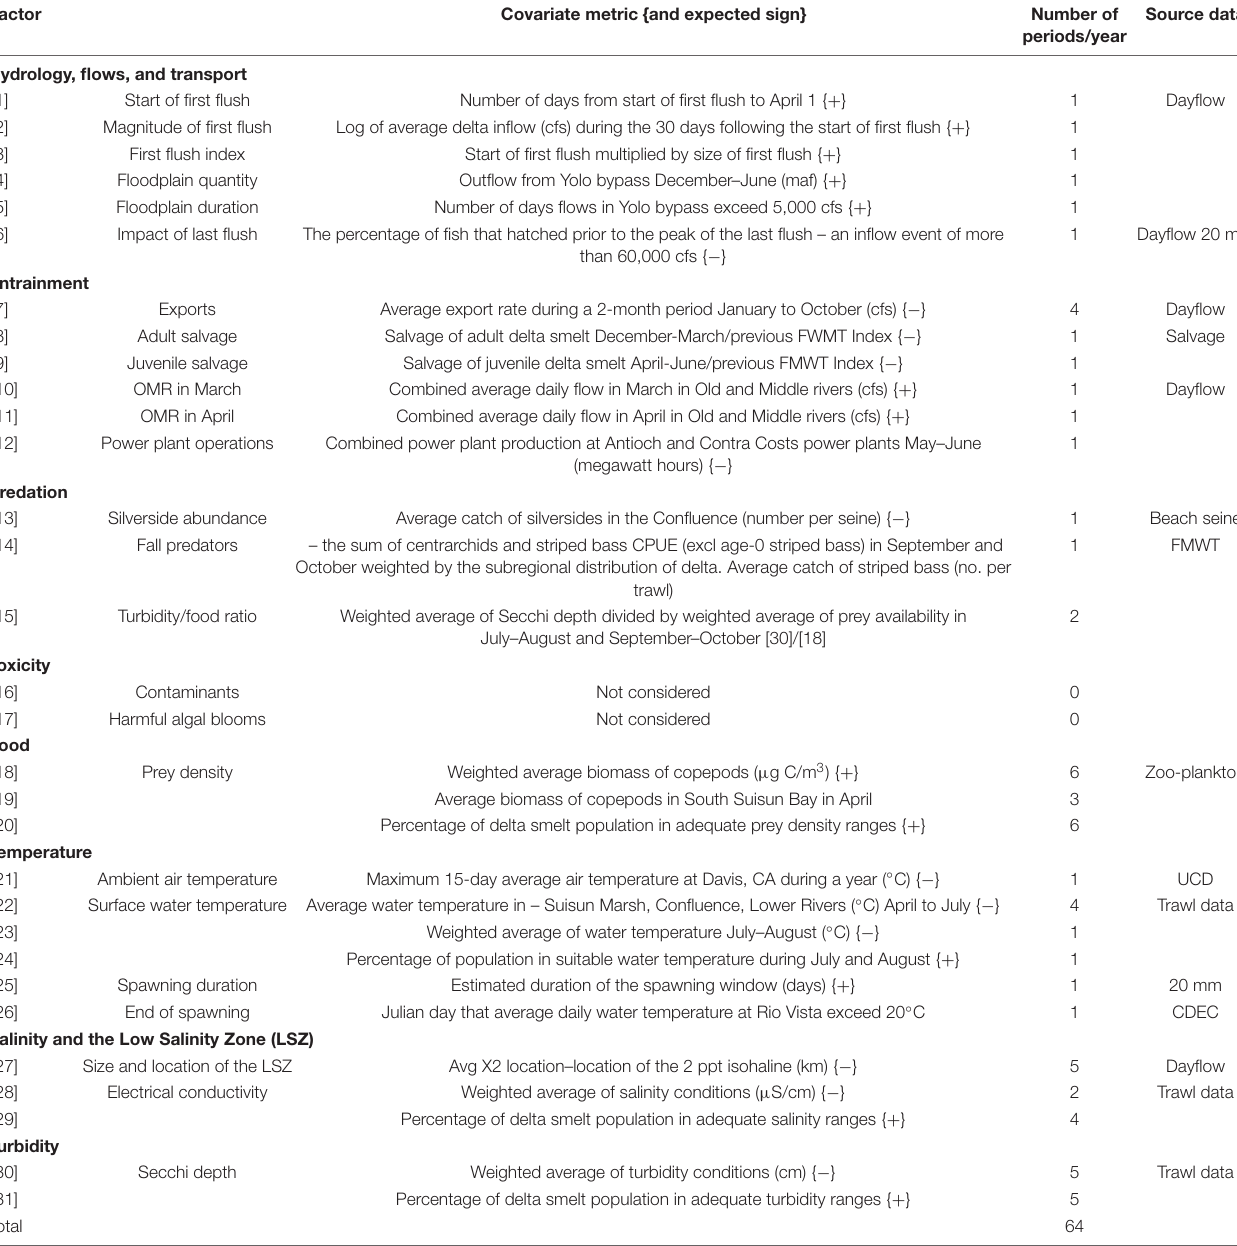
TABLE 3 | Candidate covariates included in the analysis of factors that may influence population growth rate, represented as the abundance change ratio (ACR), the ratio of the abundance-index value in 1 year relative to the abundance-index value in the prior year. Factor Covariate metric {and expected sign} Number of